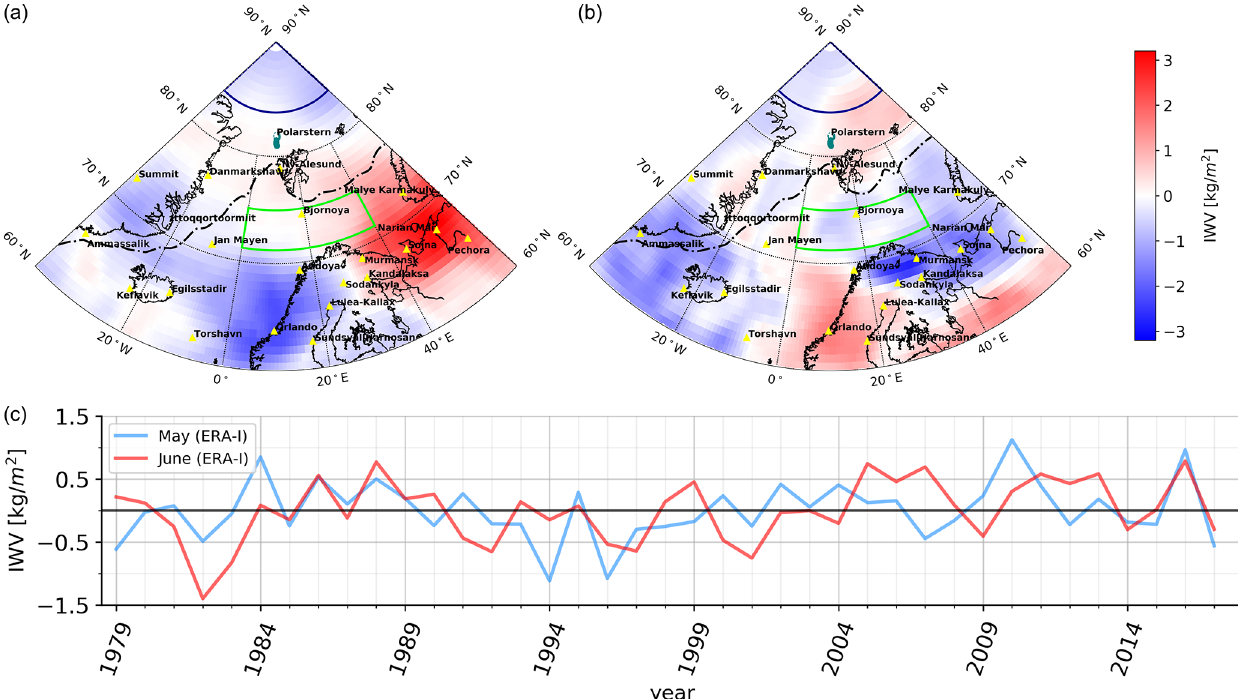
Figure 1. Study area and location of reference stations together with map of IWV anomaly with respect to ERA-Interim long-term climatol- ogy (1979–2016) for May (a) and June (b) 2017. Yellow triangles show radiosonde stations. Average sea ice margin is given as dashed black line. Two areas studied in detail are indicated in dark blue (central Arctic) and dark green (open ocean); (c) time series of IWV anomaly averaged over study area (60–90 ◦ N, 40 ◦ W–60 ◦ E) for May and June from 1979 to 2017.